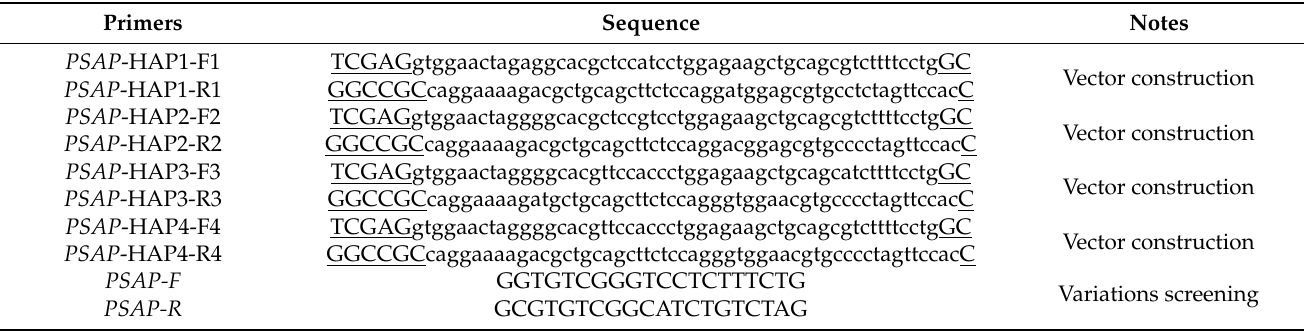
Table 2. Primers used in the sequencing and vector